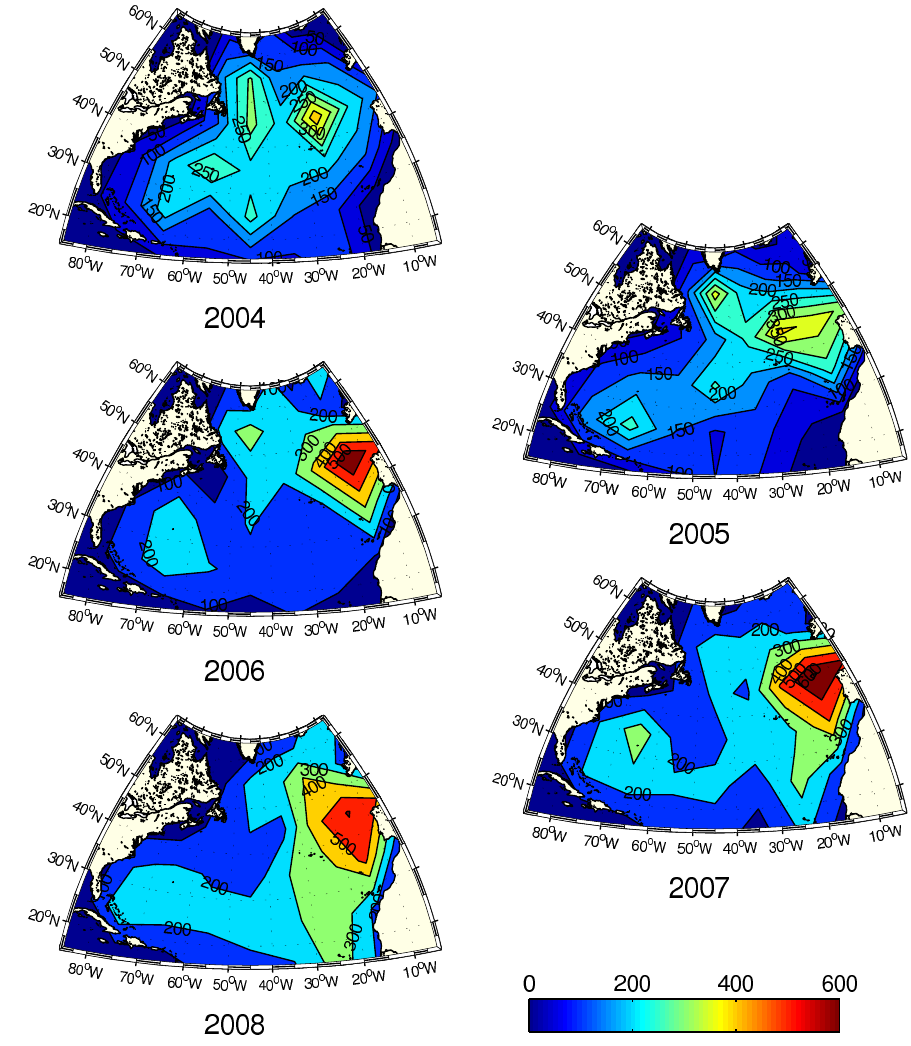
Fig. 2. The number of profiles in the 10 ◦ boxes for each year (2004–2008) after the quality control was applied.